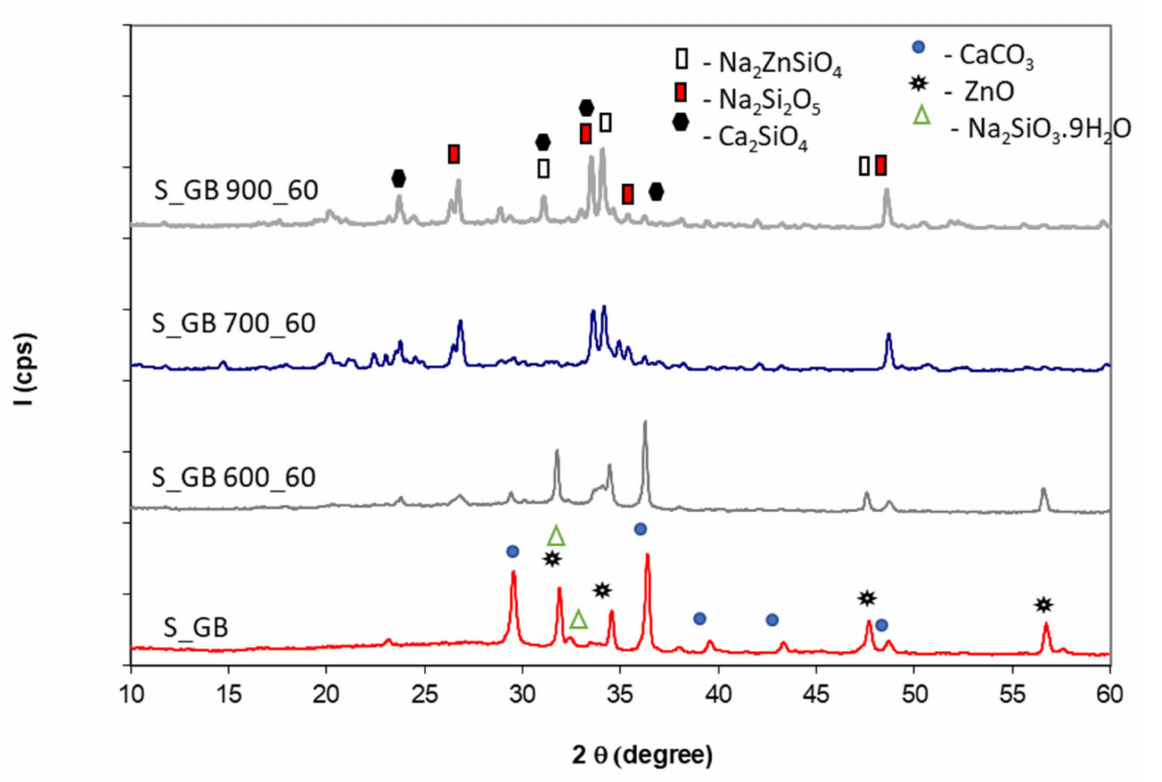
Figure 7. XRD patterns of the coating with GB addition before and after thermal treatment at 600 ◦ C, 700 ◦ C and 900 ◦ C for 60 min.